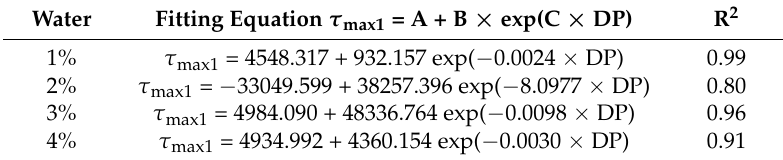
Table 2. Fitting relations between the second maximum time constants and DP values.